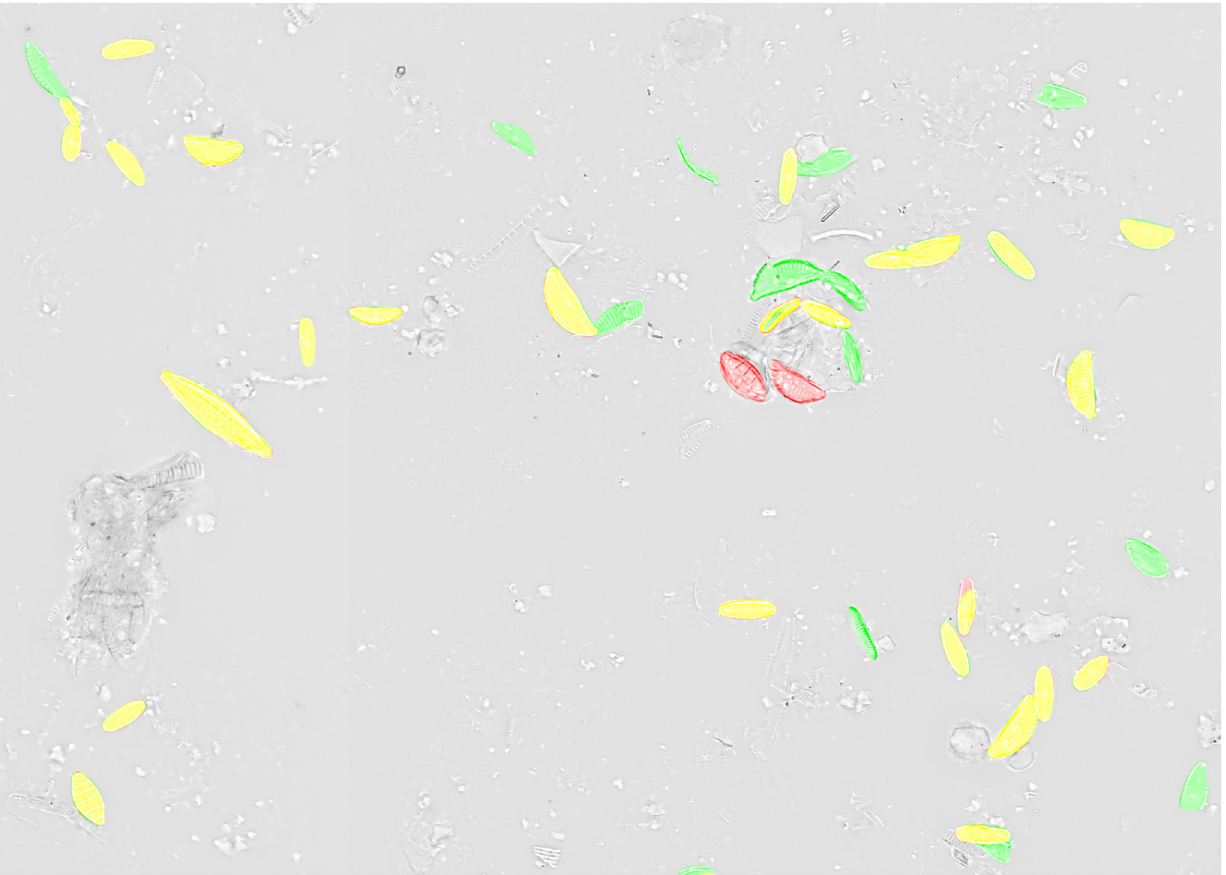
Fig 9. Comparison of predicted segmentation vs. ground truth for a Mask R-CNN model (object-based tile positioning + object integrity constraint, 100% training data) applied with a prediction score threshold of 0.9 on previously unseen test data. Yellow = true positive, red = false negative, green = false